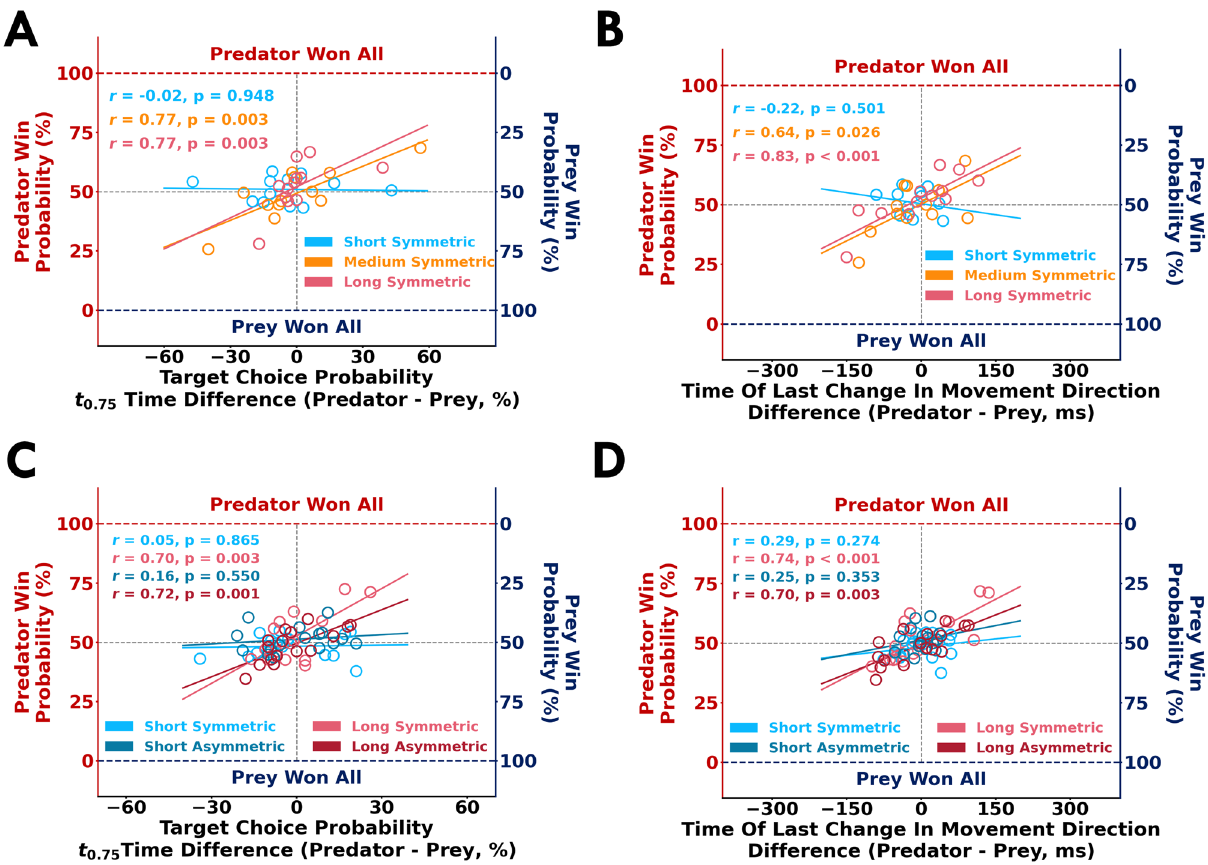
differences ( x-axis ) of the predator and prey to the win probability ( y-axis ) in ( A ) Experiment 1 and ( C ) Experiment 2. Relationship between time of last change in movement direction differences ( x-axis ) of the predator and prey to win probability ( y-axis ) in ( B ) Experiment 1 and ( D ) Experiment 2. Open circles represent pairs of competing participants. Least square regression lines are shown for each condition. With more available time, these data suggest the participants that exploited time and delayed their final reach had a greater win